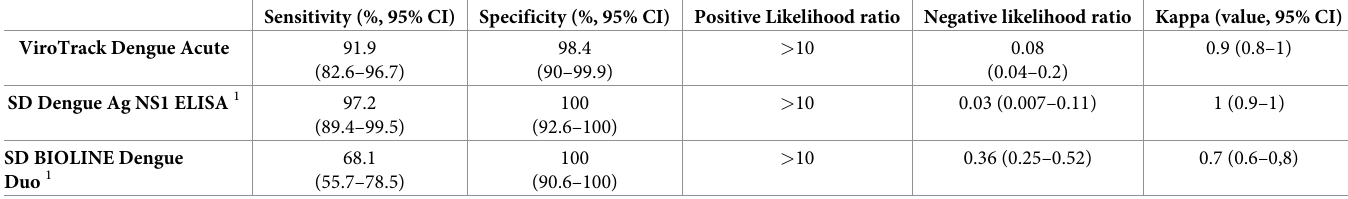
Table 1. Sensitivity, specificity, likelihood ratios and Kappa statistic results for each test with a 95% confidence interval. The gold standard used for the final diagno- sis was the DENV RT-PCR result. Sensitivity (%, 95% CI) Specificity (%, 95% CI) Positive Likelihood ratio Negative likelihood ratio Kappa (value, 95% CI) ViroTrack Dengue